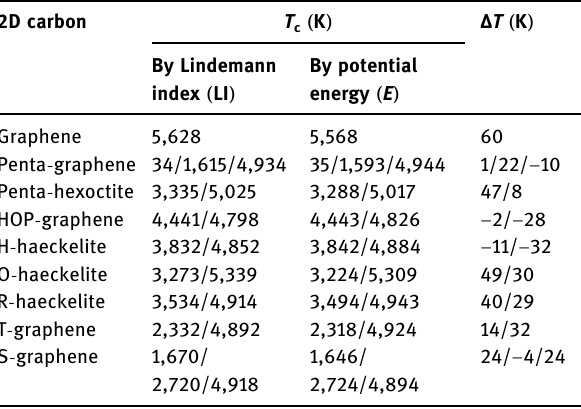
Table 1: Critical temperatures of 2D carbon crystals using LI and potential